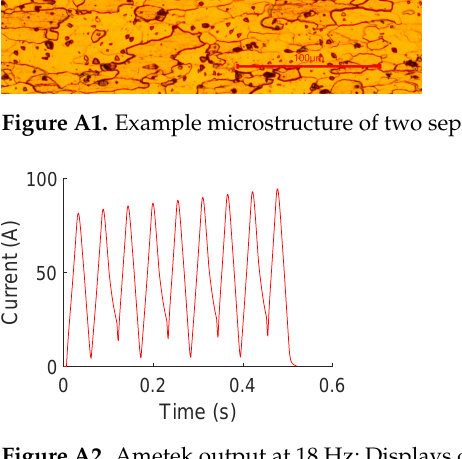
Figure A2. Ametek output at 18 Hz; Displays distorted waveshape.